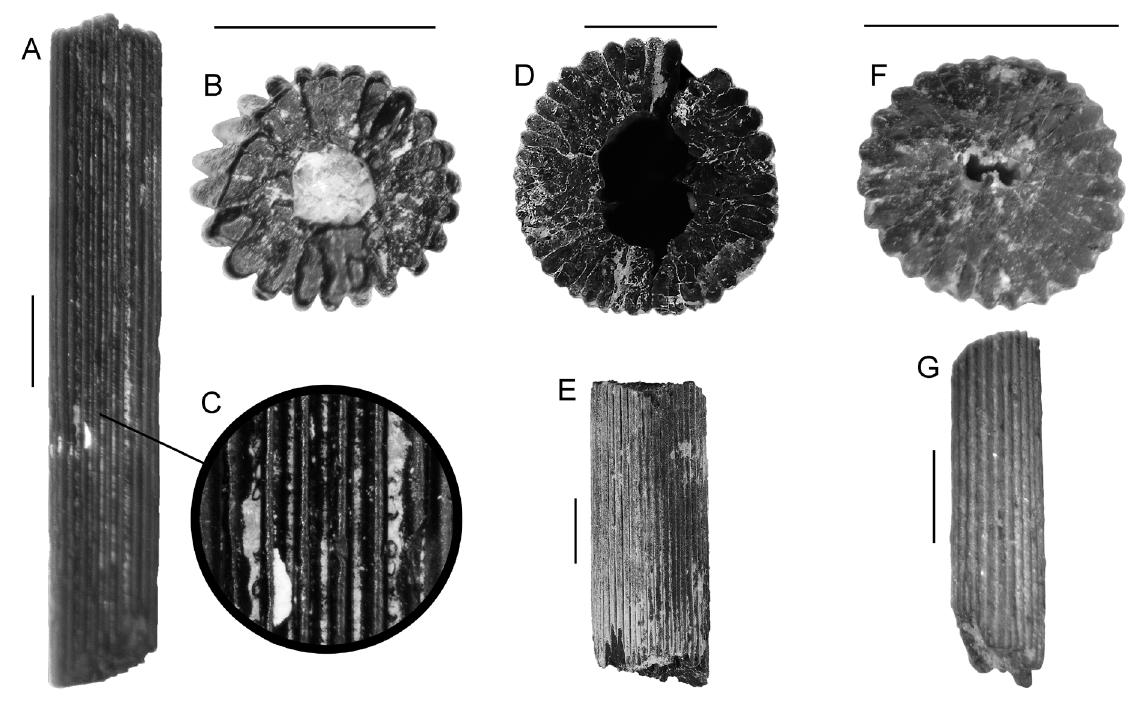
Fig. 56. Cylindracanthus Leidy, 1856, rostra. A–C . Cylindracanthus ornatus Leidy, 1856, SC2012.47.153, basal Lisbon Formation. A . Ventral view. B . Cross–section. C . Close–up of denticle rows. — D–G . Cylindracanthus rectus (Agassiz, 1843). D–E . MSC 38378, “upper” Lisbon Formation. D . Cross–section. E . Lateral view. F–G . WSU 5019, basal Lisbon Formation. F . Cross–section. G . Lateral view. Scale bars: A–C = 2 mm; D–G =